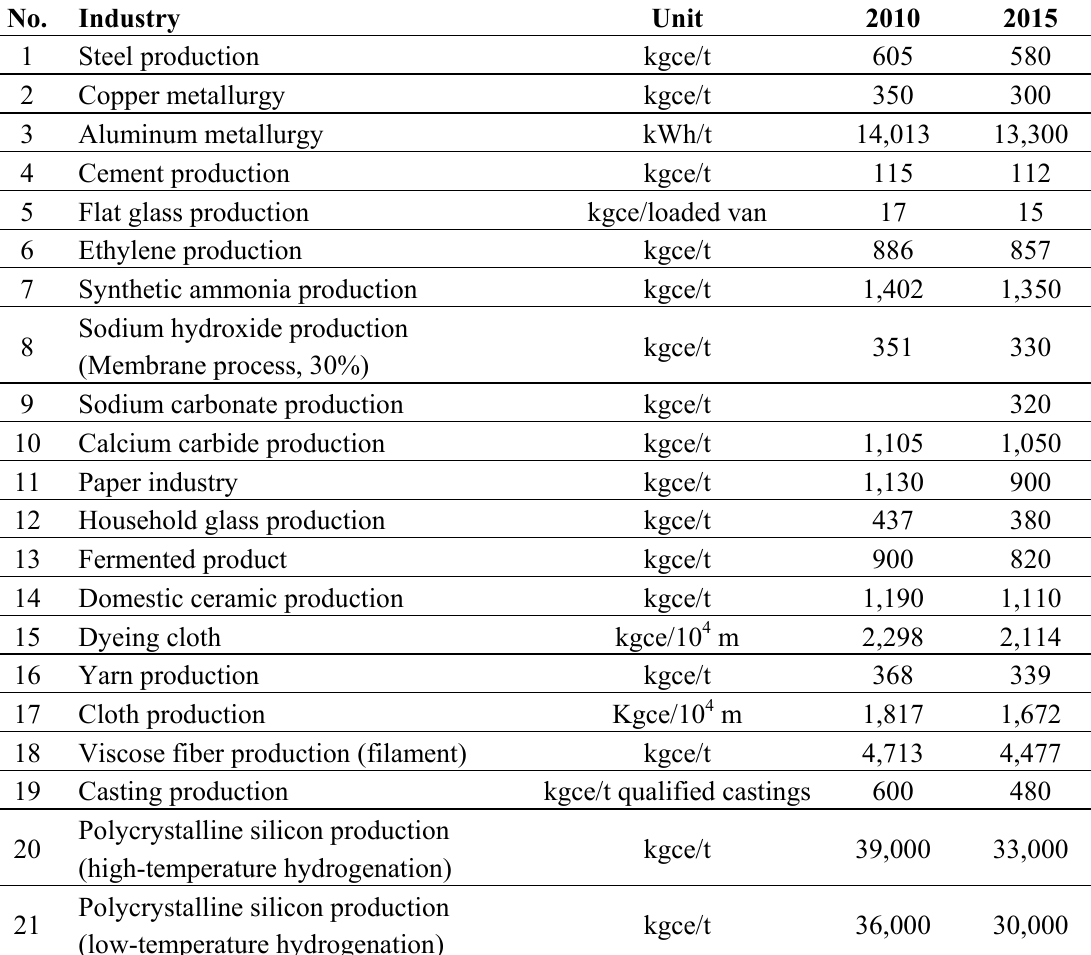
Table 2. Energy consumption targets for energy-intensive industries.